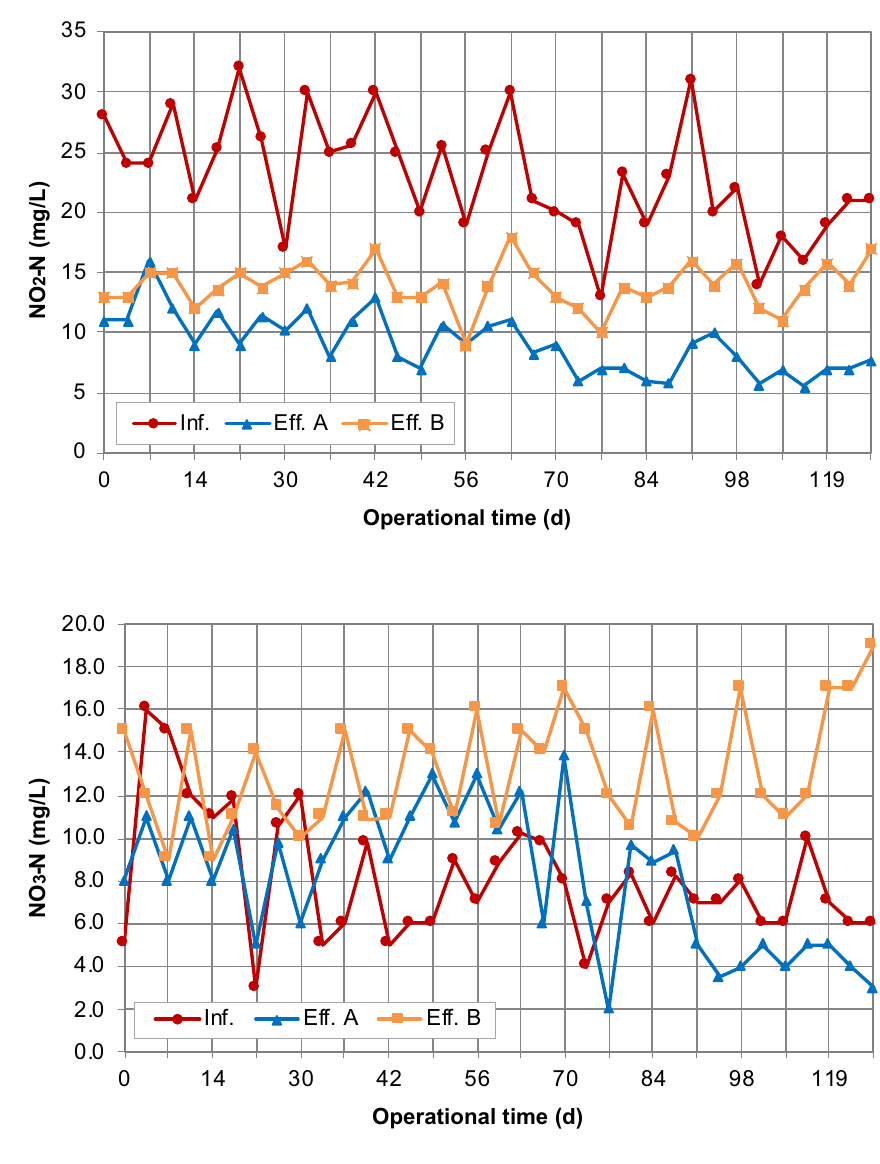
Fig. 7 Profile of influent–efflu- ent nitrite concentration for SBR A and SBR B